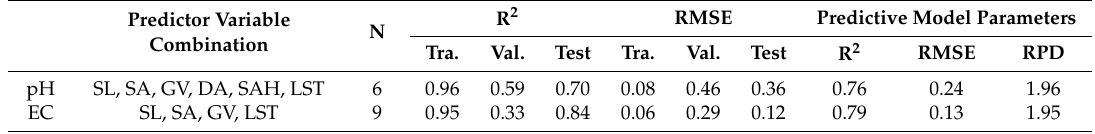
Table 7. Optimal ANN model performances and parameters for soil pH and EC estimations.